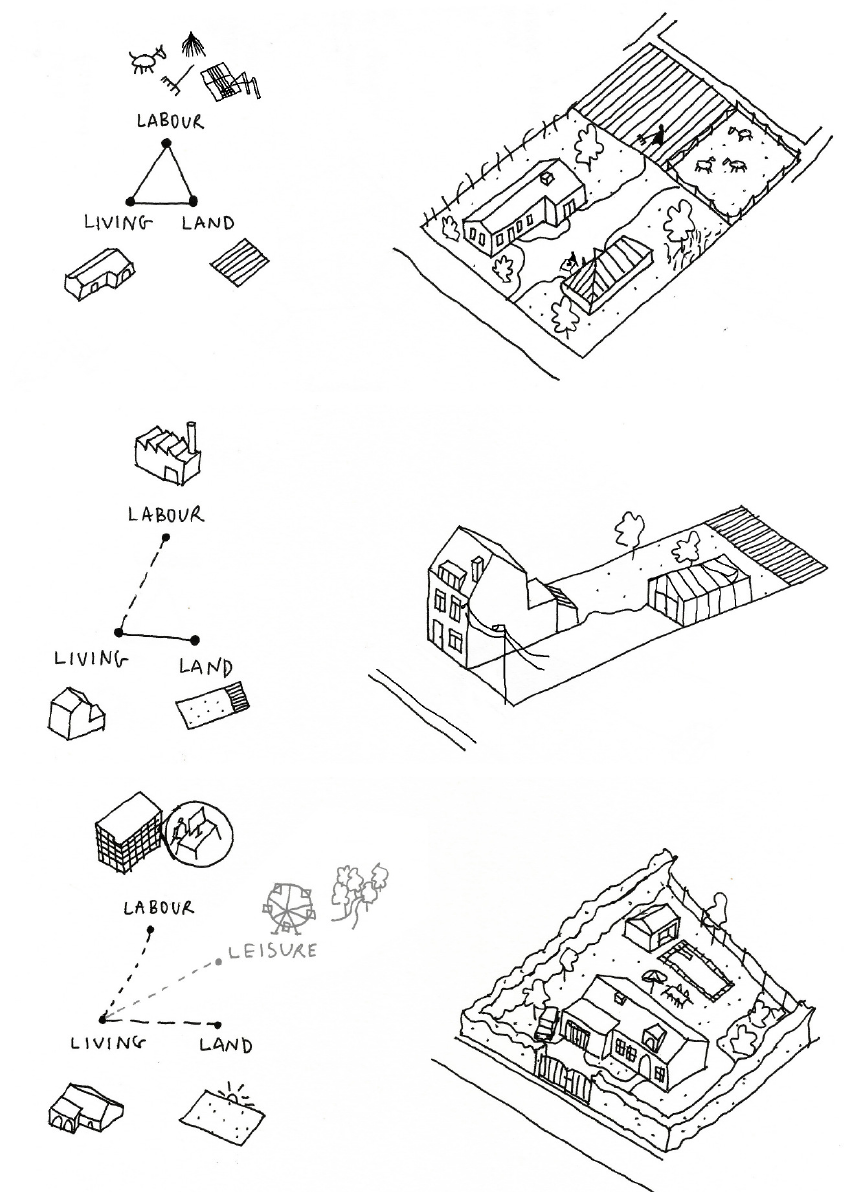
Figure 8. Different architectural typologies expressed different societal shifts: The farm (top), the semi‐detached dwelling (middle), and the fermette (bottom). Source: Figure elaborated by Sophie Leemans, 2022. year after year, the urge to intervene grows as